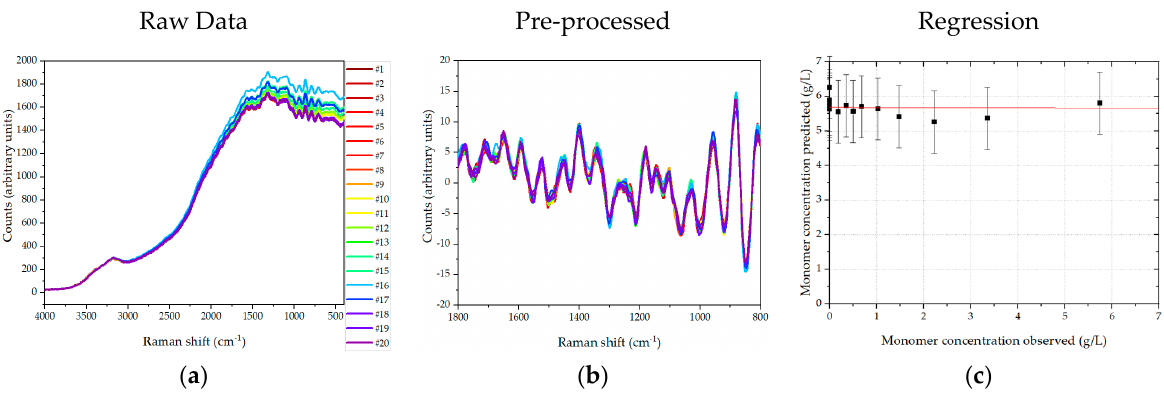
Figure 7. Data of Raman spectra ( a ), pre-processed spectra ( b ) and PLS results ( c ). Spectra are color-coded from high concentration (blue) to low concentration (red).